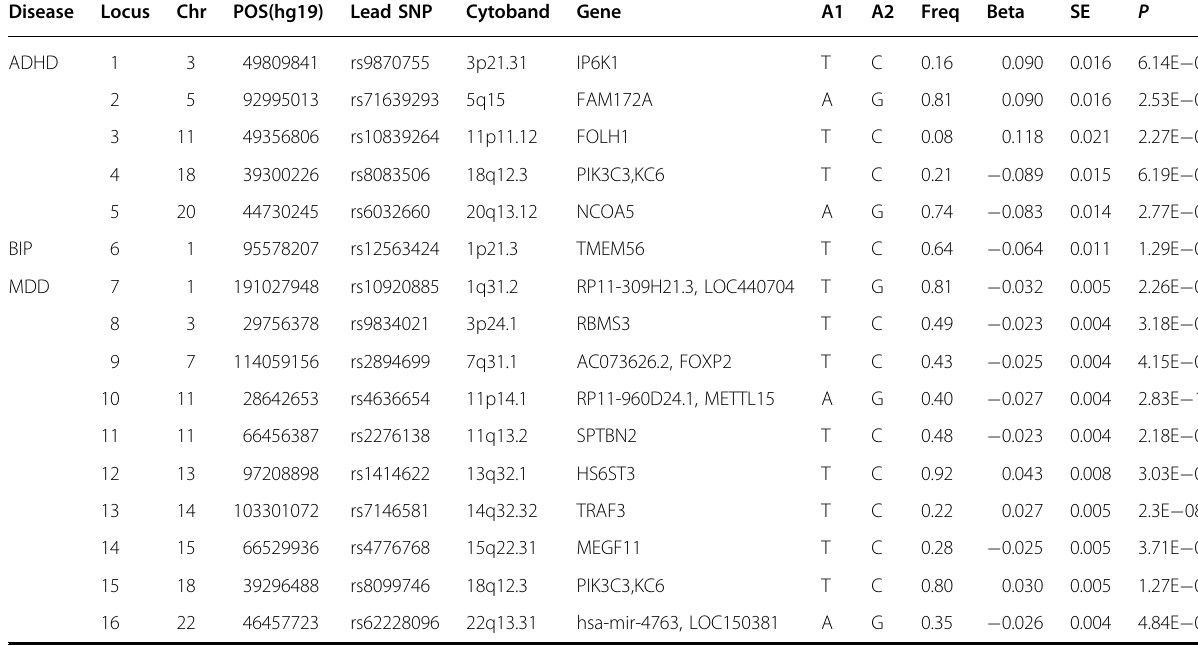
Table 1 Novel genome-wide signi fi cant loci from multi-trait joint-analyses of neuropsychiatric disorders. Disease